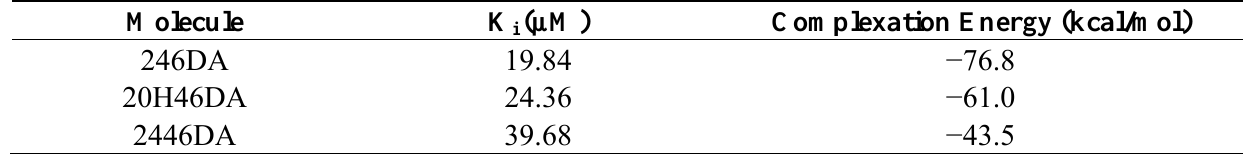
value of the synthetic i